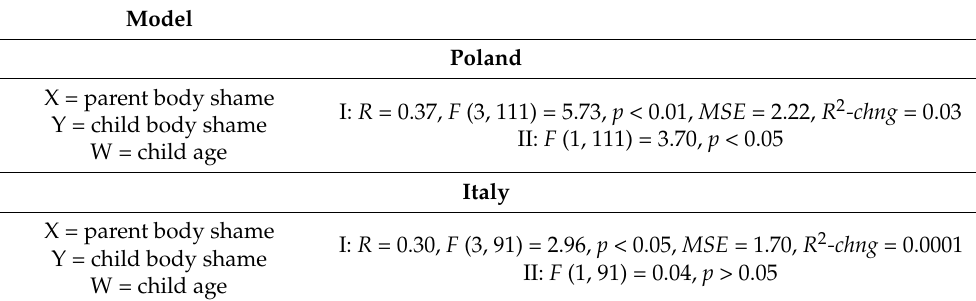
Table 6. Moderation analysis: results of models summaries (I) and tests of higher orders of uncondi- tional interactions (II).